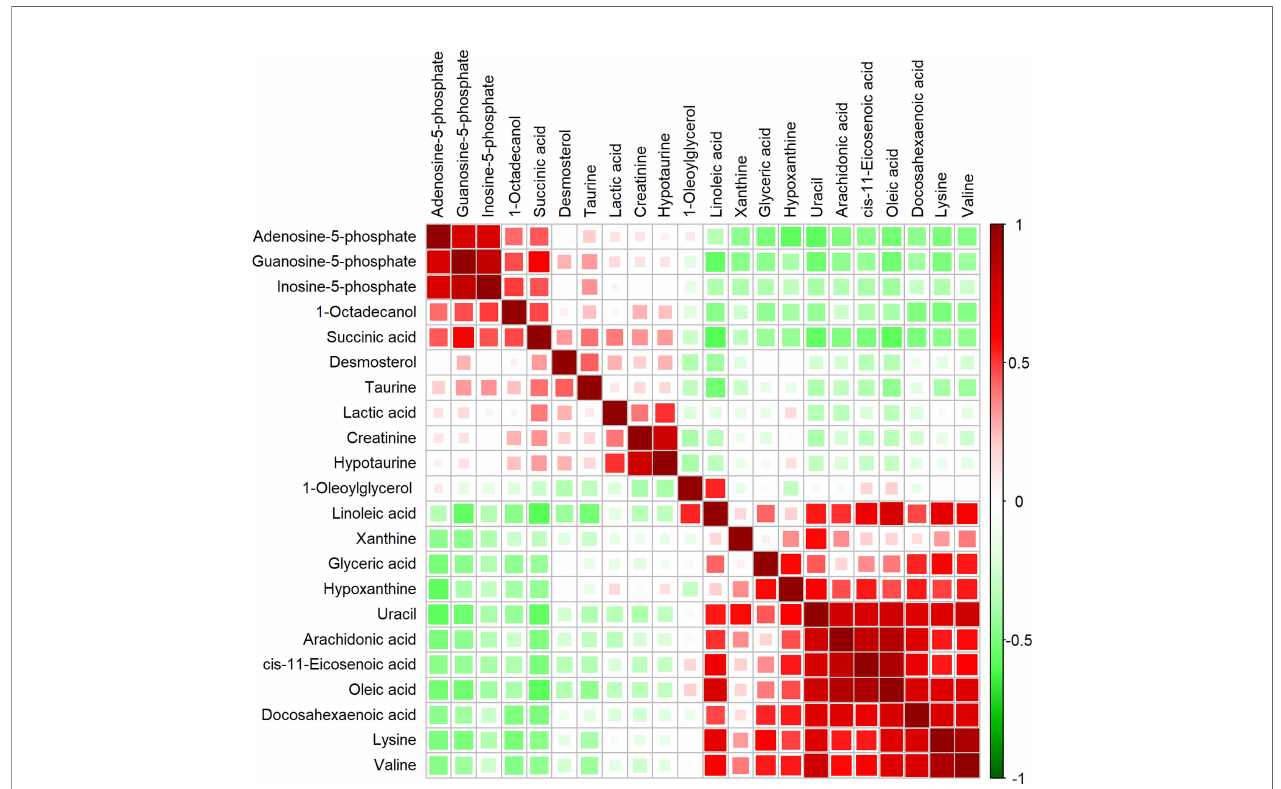
FIGURE 2 | Correlation matrix obtained from signi fi cantly altered metabolites between invasive nonfunctioning pituitary adenoma (NFPA) and non-invasive NFPA tissues. Differential metabolites are represented in each row and column. The correlation coef fi cient values are shown on the right side of the fi gure. The size and color of the squares in the fi gure are related to the correlation between the differential metabolites. Red indicates a positive correlation between differential metabolites, and green indicates a negative correlation between differential metabolites.